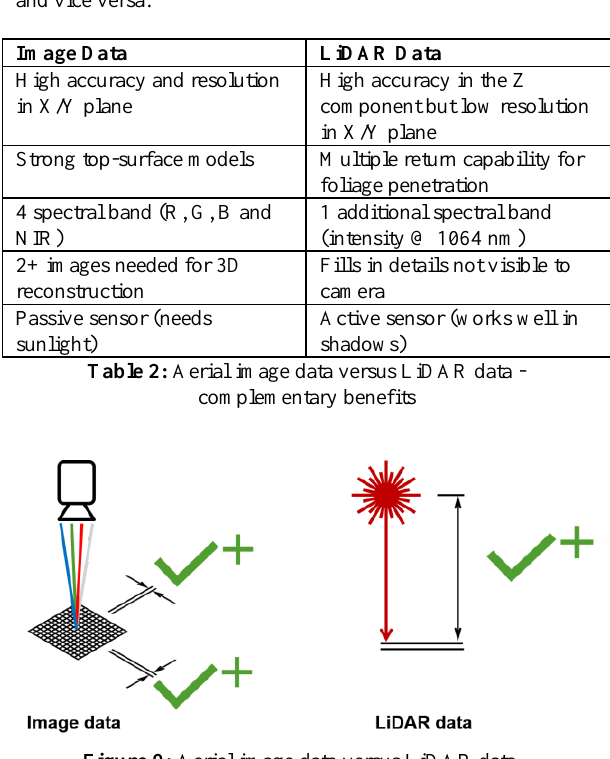
Figure 9: Aerial image data versus LiDAR data - complementary benefits